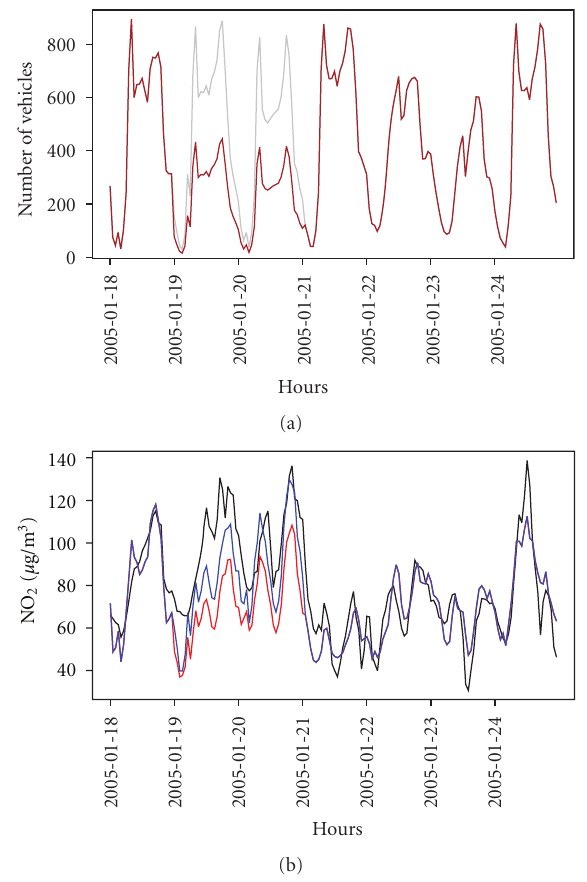
Figure 11: (a) Tra ffi c volume in January, 18–24, 2005; original data in grey, policy scenario tra ffi c volume in red. (b) NO 2 concentration in January, 18–24, 2005; measured data in black, predicted values without (blue) and with (red) tra ffi c policy